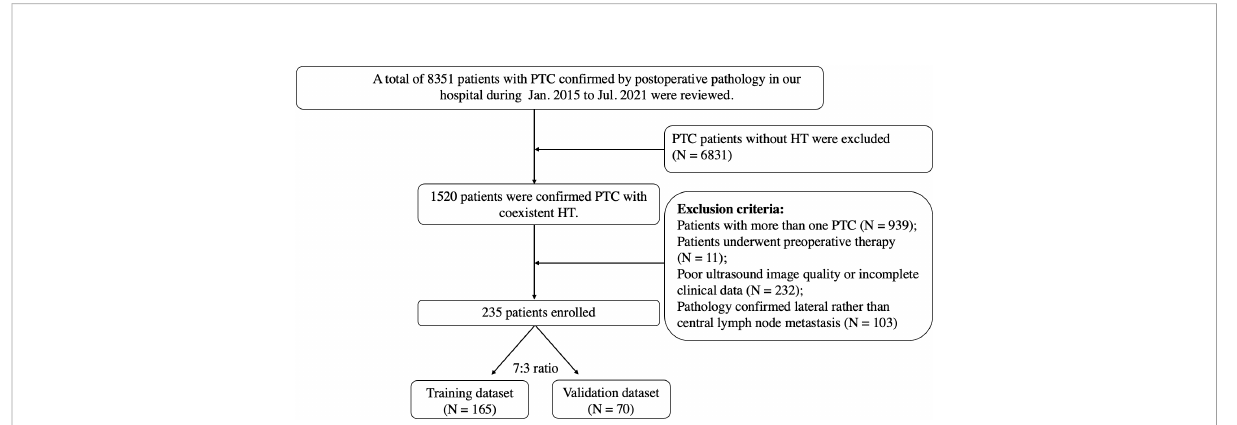
FIGURE 1 Flowchart of patient selection for differentiating CLNM of PTC patients with HT. PTC, papillary thyroid carcinoma; HT, Hashimoto ’ s thyroiditis; CLNM, central lymph node